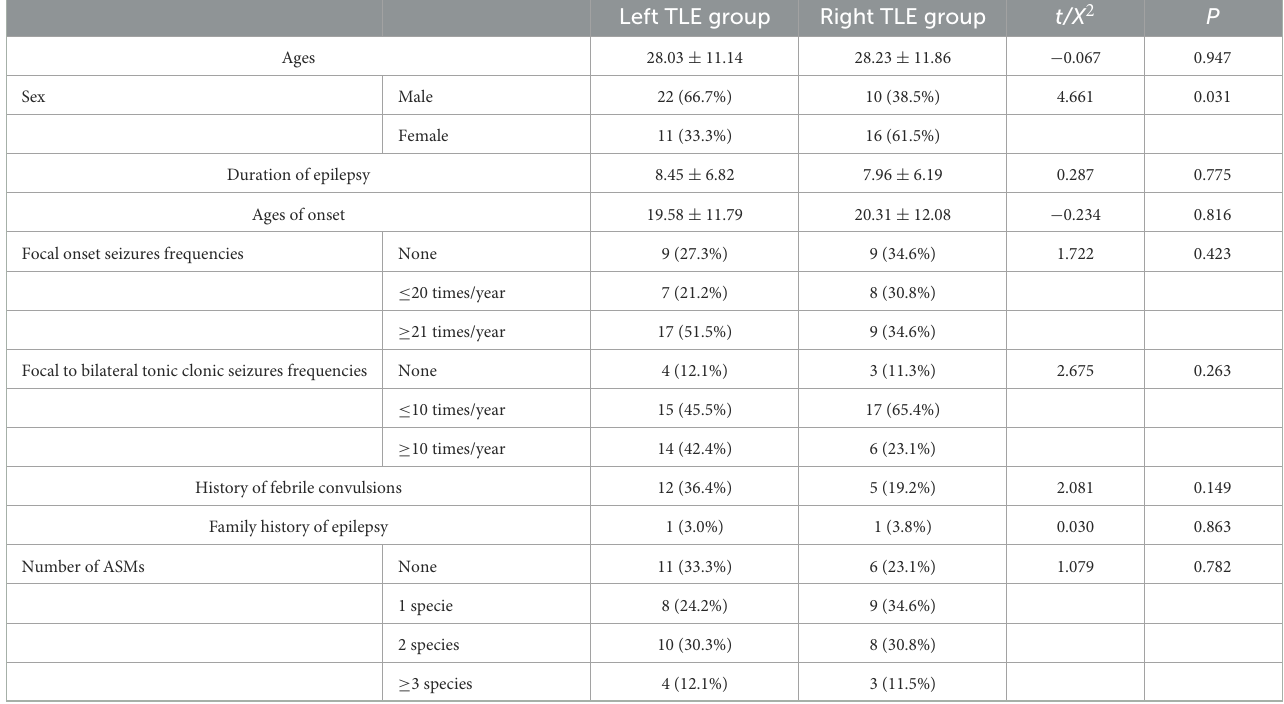
TABLE 1 Demographic and clinical characteristics of the study